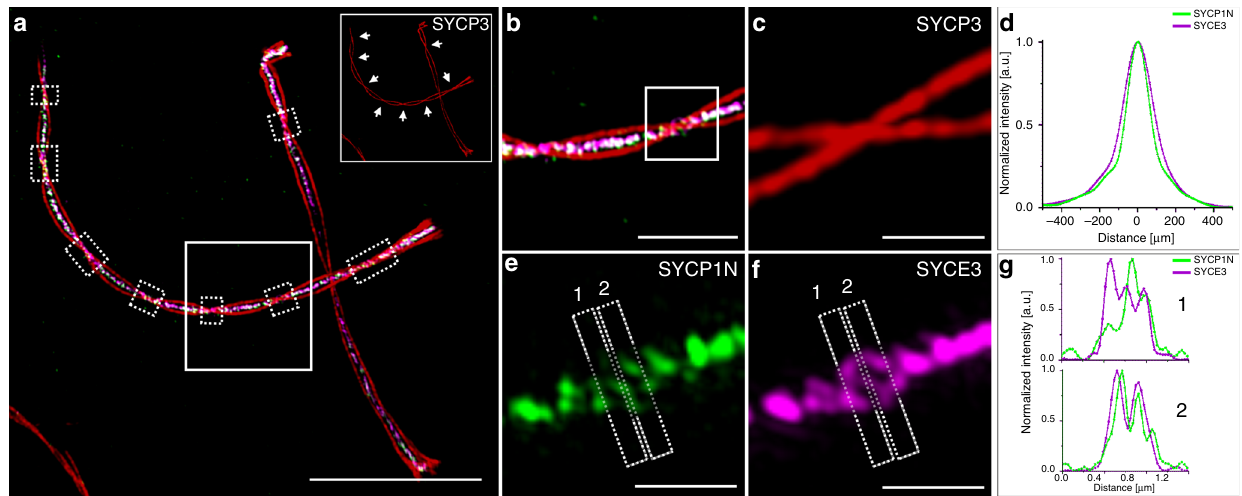
Fig. 4 MAP-SIM reveals a complex organization of the SC central region. a MAP-SIM image of SYCE3 labeled with Alexa Fluor 568 (magenta), SYCP1N labeled with Alexa Fluor 488 (green) and SYCP3 labeled with SeTau647 (red). Lateral view sections of the SC are visualized as twists in the SYCP3 signal (marked by white dotted boxes and indicated by arrows in the inlet of ( a ) showing only the SYCP3 channel). b Magni fi ed view of white boxed region in ( a . c , e , f ) Enlarged views of highlighted region in ( b ) showing the SYCP3 signal in red ( c ), the SYCP1N signal in green ( e ) and the SYCE3 signal in magenta ( f ) with two sites selected for protein distribution analysis (1, 2). d Averaged pro fi le of all cross-sectional intensity pro fi les along the SYCE3 (magenta) and SYCP1N (green) signals analyzed at regions speci fi ed in ( a ) by white dotted boxes showing a monomodal signal distribution of 168.0 ± 1.1 nm (SD) for SYCP1N and 211.43 ± 0.89 nm for SYCE3 derived from single Gaussian fi tting. g Cross-sectional intensity pro fi les of lateral view sections 1 and 2 of the SC (indicated in e and f ) show a multimodal organization of the central element protein SYCE3 (magenta) and the N terminus of SYCP1 (green). Scale